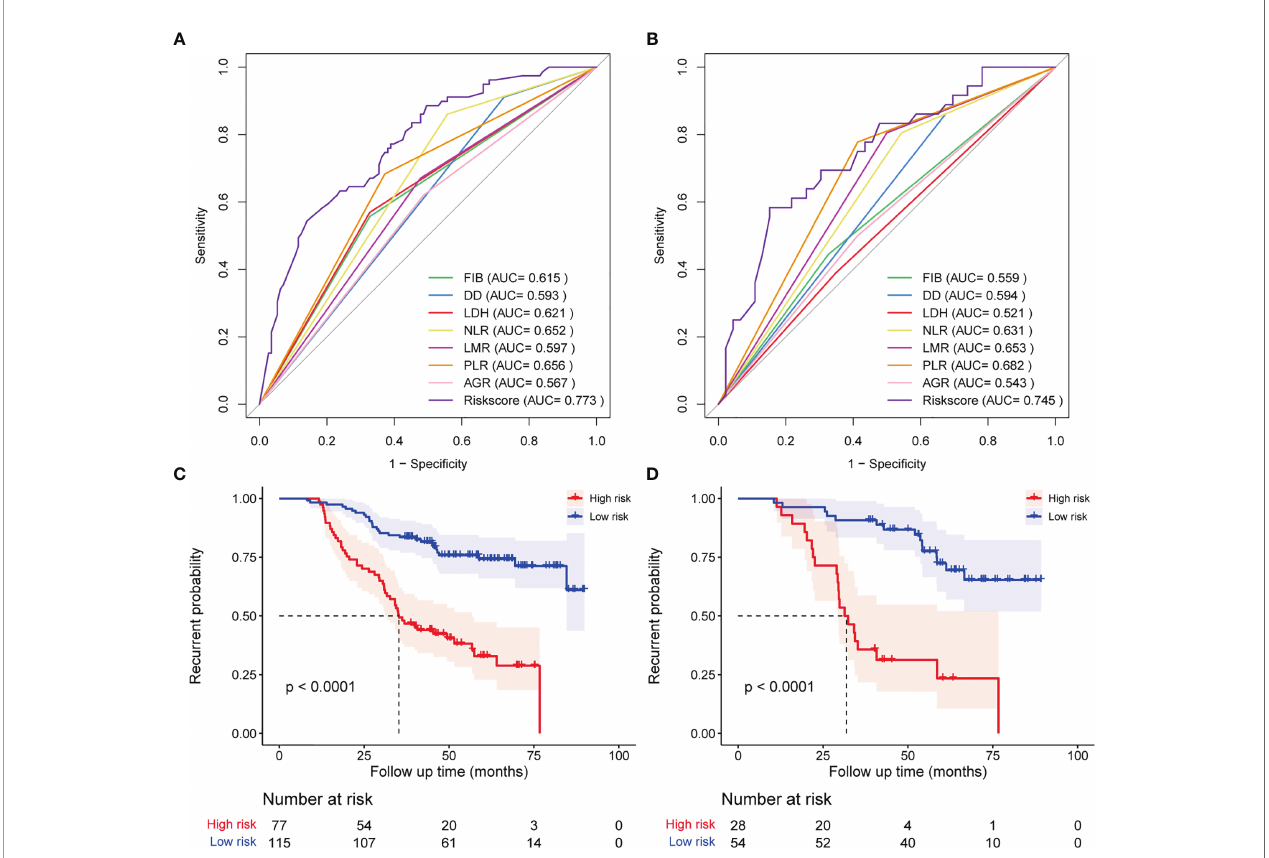
FIGURE 1 | Diagnostic accuracy and prognostic performance assessment of the hematological risk model (HRM). ROC curve shows the difference in diagnostic accuracy between HRM and a single hematological parameter at the end of follow-up in the training cohort (A) and test cohort (B) . Kaplan-Meier survival analysis for progression-free survival of patients classi fi ed by hematological risk in the training cohort (C) and test cohort (D)